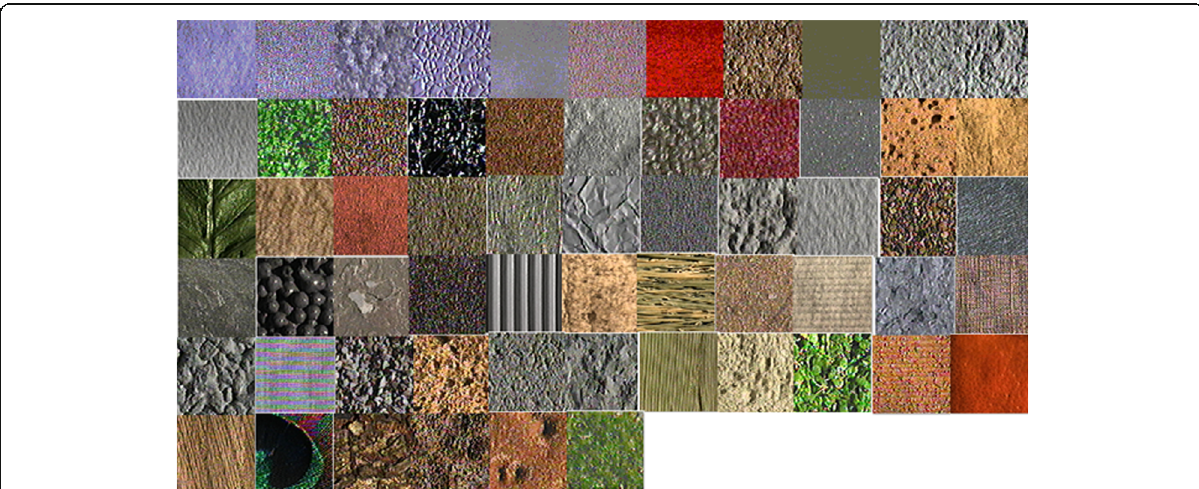
Fig. 11 Various texture classes of images from CUReT